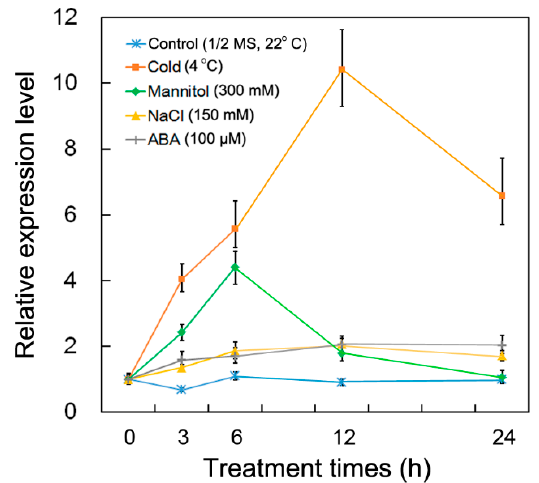
Figure 2. Expression of PsCor413pm2 under multiple stresses. Two-week-old Phlox subulata seedlings were treated with cold (4 °C), mannitol (300 mM), NaCl (150 mM), and abscisic acid (ABA) (100 μ M) for 0, 3, 6, 12, and 24 h. The PsActin gene was used as an internal control, and the transcript level in the untreated seedlings was set as 1.0. Error bars show the standard deviation (SD) of the values from three replicates.